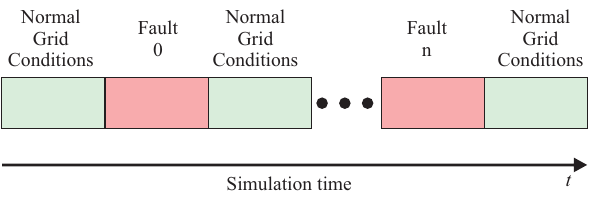
Figure 7. Fault induction sequence.